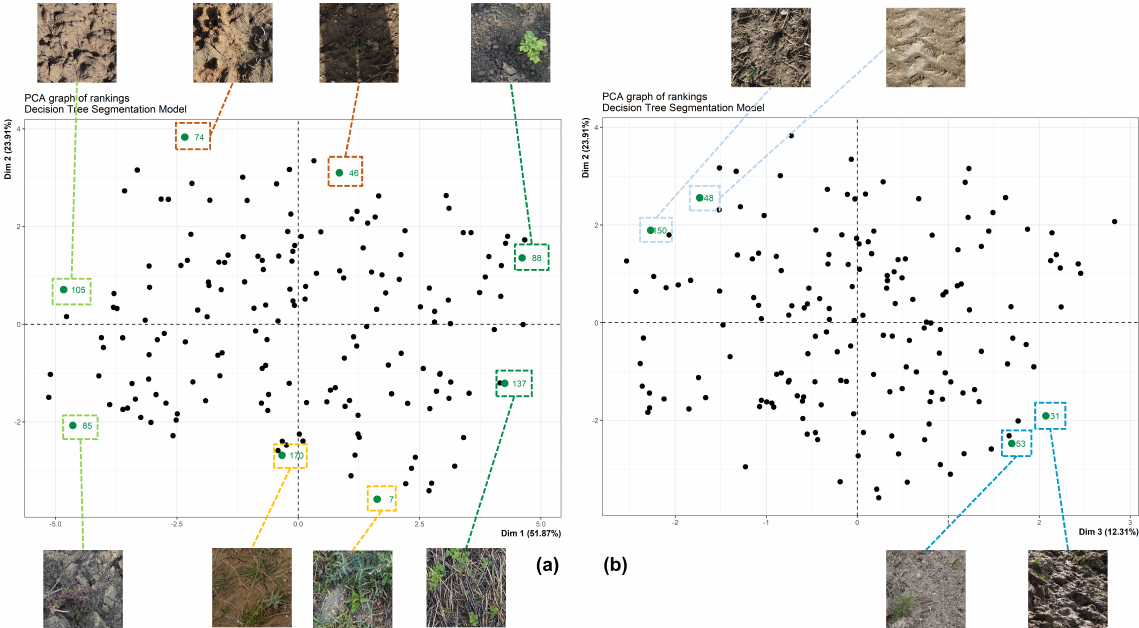
Figure 6. Representative images for each group of metrics and their locations in the projected point clouds in the principal planes formed by: ( a ) 1st and 2nd PCs; ( b ) 3rd and 2nd PCs. These good segmentations can be contrasted with the leftmost images, the supposedly worst evaluated images by the green metrics, of which we exhibit Images 85 and